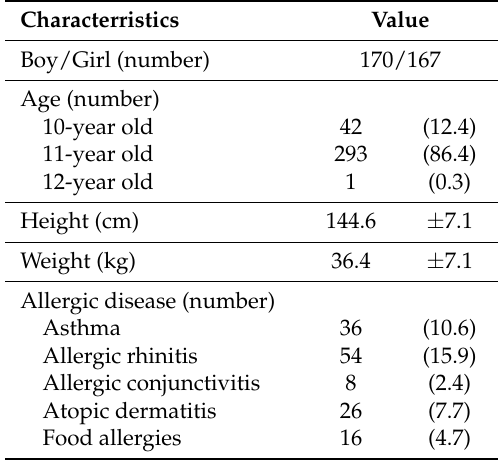
Table 1. Characteristics of the 339 children included in this study.